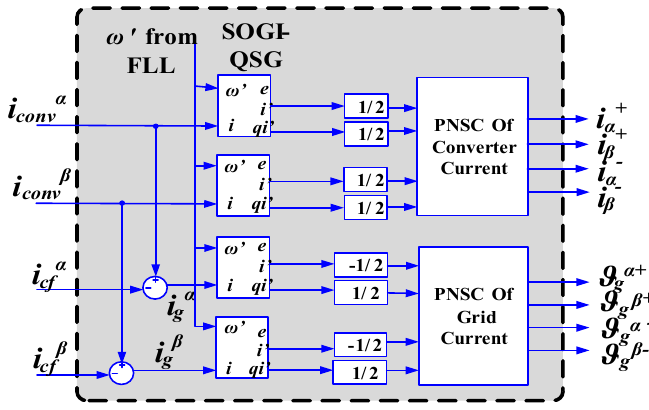
Figure 6. Sequence separation of converter currents and the grid current integral.